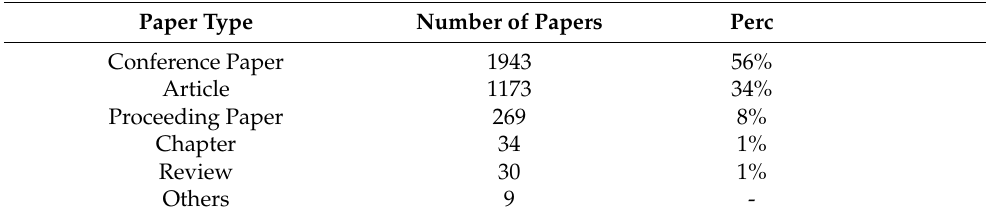
Table 2. Numbers of different paper types and their